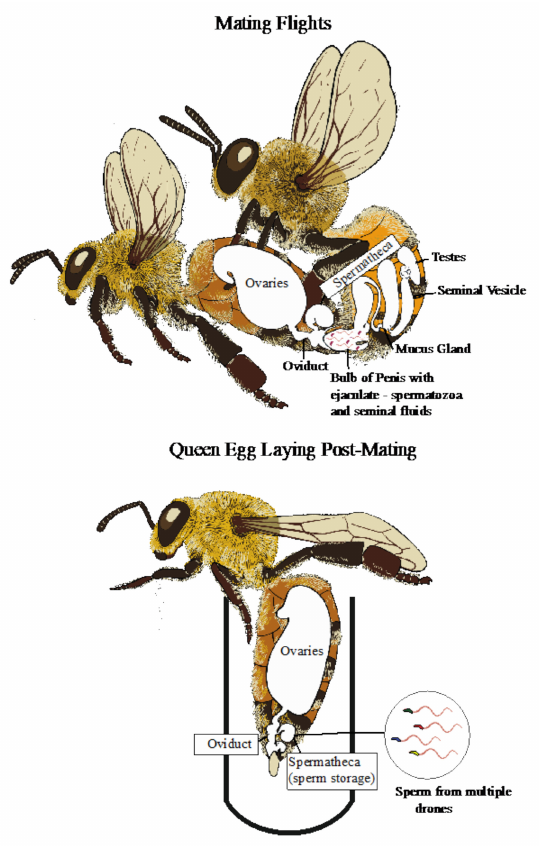
Figure 2. During insemination, drones transfer both spermatozoa and seminal fluids into the queen’s oviduct, which will eventually become stored in the spermatheca. Once stored, queens will use this sperm until death. Photo credit: Amy